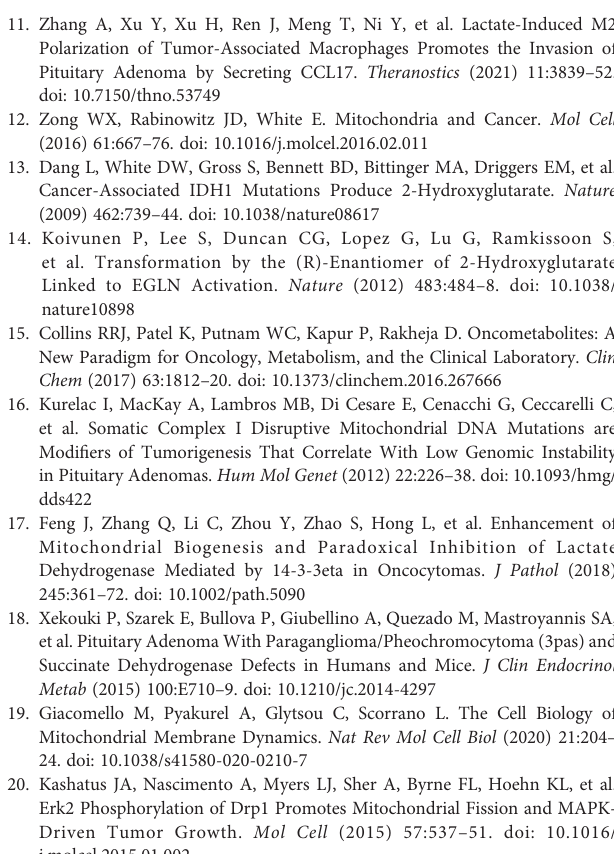
Supplementary Figure 1 | (A – C) Expression of Mfn1, Mfn2 and OPA1 mRNA levels were assessed by RT-qPCR in NIGHPAs (n = 12) and IGHPAs (n = 13) samples. (D) Representative electron microscopic images of mitochondria in four GH3 cell groups (VE, VE+Mdivi-1, Drp1 ++/++ , Drp1 ++/++ +Mdivi-1). # P > 0.05. Scale bar = 0.5 um. Supplementary Figure 2 | (A) Cell cycle of GH3 cells in four groups (VE, VE +Mdivi-1, Drp1 ++/++ , Drp1 ++/++ +Mdivi-1) at 48 h were analyzed by fl ow cytometry (n = 3). (B) . Cell apoptosis at 48 h were analyzed by fl ow cytometry (n = 3). (C) Mitochondrial membrane potential of four GH3 cell groups were detected by fl ow cytometry using Rhodamine123 at 48 h (n = 3). (D) Reactive oxygen species (ROS) were detected by fl ow cytometry using DCF-DA fl uorescence at 48 h (n = 3). Supplementary Figure 3 | (A) Cell cycle of GH3 cells in three groups (VE+Mdivi- 1, VE+Mdivi-1+HO-3867, VE+Mdivi-1+Cry) at 48 h were analyzed by fl ow cytometry(n=3). (B) Cellapoptosisat48hwereanalyzedby fl owcytometry(n=3). (C) Mitochondrial membrane potential of three GH3 cell groups were detected by fl ow cytometry using Rhodamine123 at 48 h (n = 3). (D) Reactive oxygen species (ROS) were detected by fl ow cytometry using DCF-DA fl uorescence at 48 h (n = 3). Supplementary Figure 4 | The invasion and proliferation of MMQ and PAPCs were affected by Drp1 via STAT3. (A) MMQ cell invasion were evaluated by transwell assay when treated with Mdivi-1, Mdivi-1+HO-3867, Mdivi-1+Cry (n = 3). (B) Statistical analysis of the invasive MMQ cell number in the four groups. (C) The number of MMQ cells in four groups were assessed by CCK-8 assay (n = 3). (D) PAPCs cell invasion were evaluated by transwell assay when treated with Mdivi- 1, Mdivi-1+HO-3867, Mdivi-1+Cry (n = 5). (B) Statistical analysis of the invasive PAPCs cell number in the four groups. (C) The number of PAPCs cells in four groups were assessed by CCK-8 assay (n = 5). *P < 0.05, ***P < 0.001. Data were expressed as mean ±